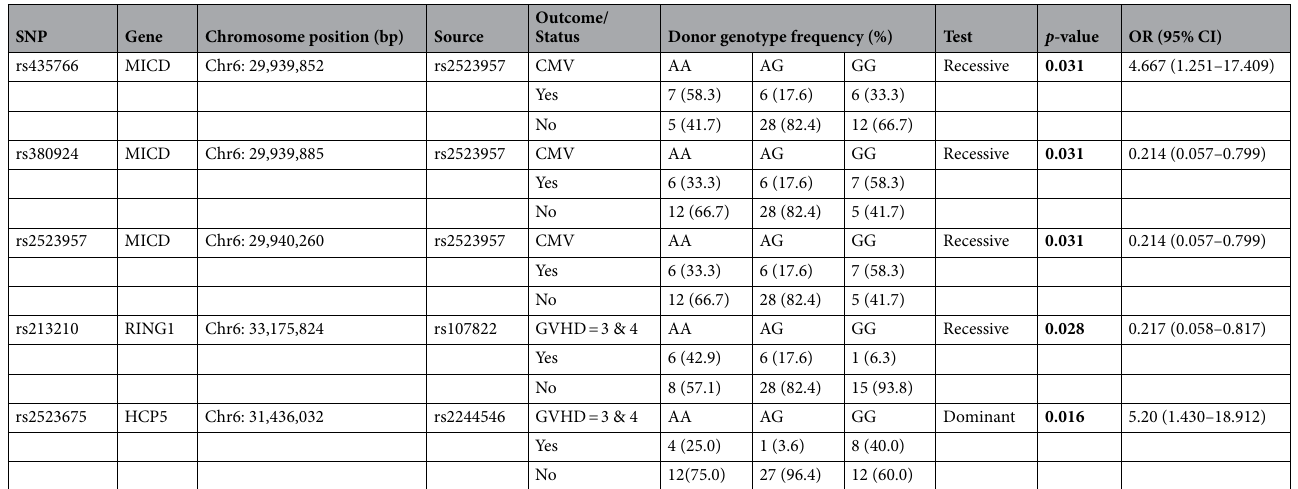
Table 4. The SNPs associated with the outcomes of unrelated CBT in donor genotype analysis. Dominant: dominant model (AA vs. Aa + aa); Recessive: recessive model (AA + Aa vs. aa), in which “A” was defined as a higher frequency allele and the lower was “a”. Data were analyzed by Chi-square test or Fisher’s exact